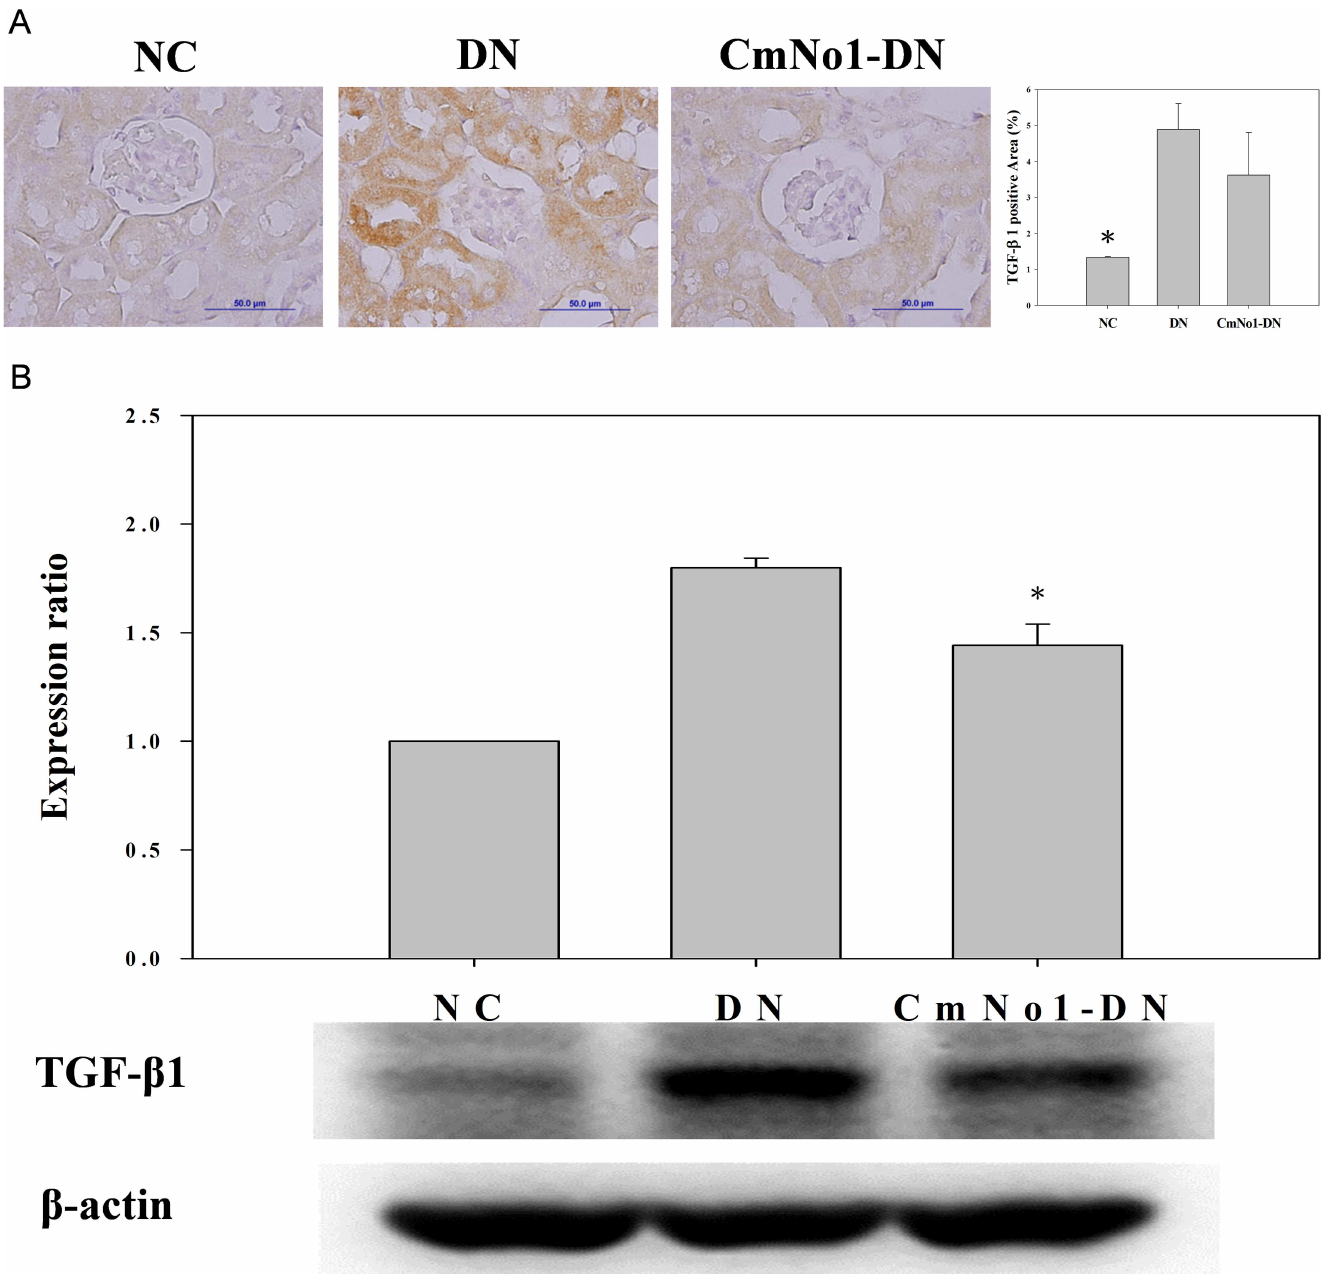
Fig 5. Immunohistochemical staining of TGF- β 1 protein in mouse kidney. (A) TGF- β 1 immunostaining in NC, DN and CmNo1-DNgroup mice while (B) Western blot profile of TGF- β 1 protein expressionand quantification. Symbols specify significantdifference from DN with * indicate p < 0.05. NC: Normal control; DN: Diabeticnephropathy; CmNo1-DN: Diabeticnephropathygroup mice treated with Cordycepsmilitaris No1.